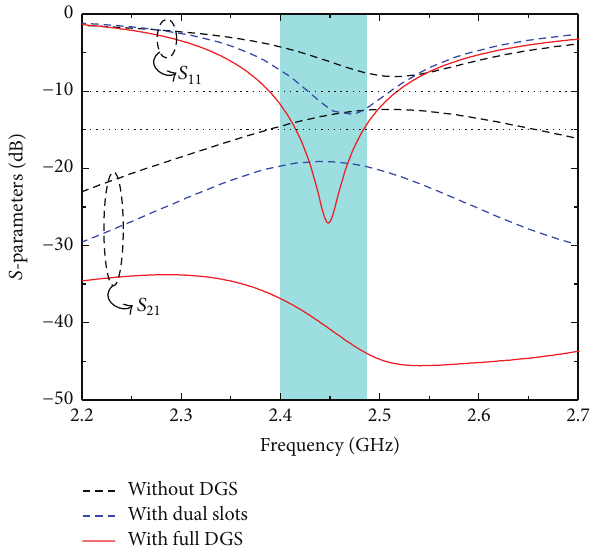
Figure 6: Simulated radiation pattern of single metamaterial ante- nna at center frequency of 2.44 GHz.